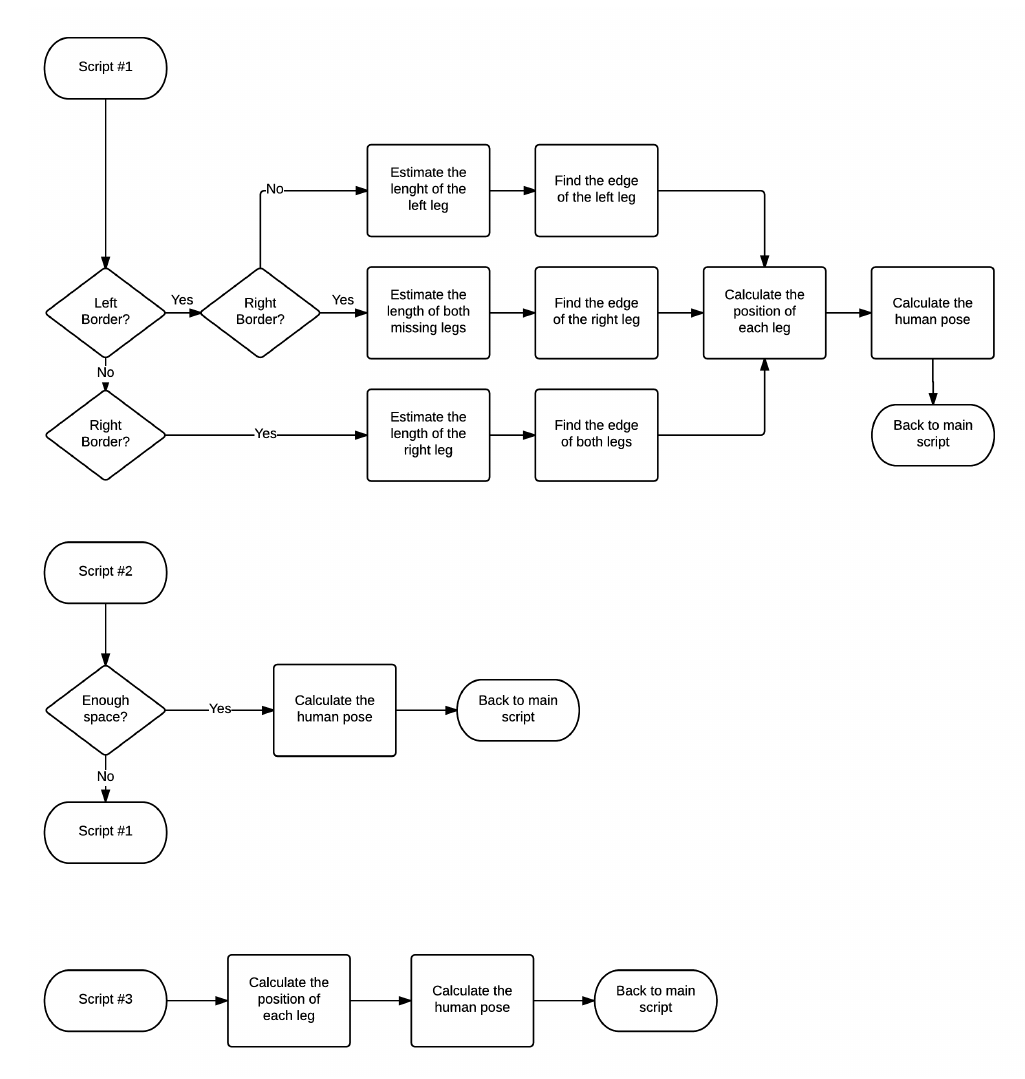
Figure 8. Details of the scripts for each kind of leg